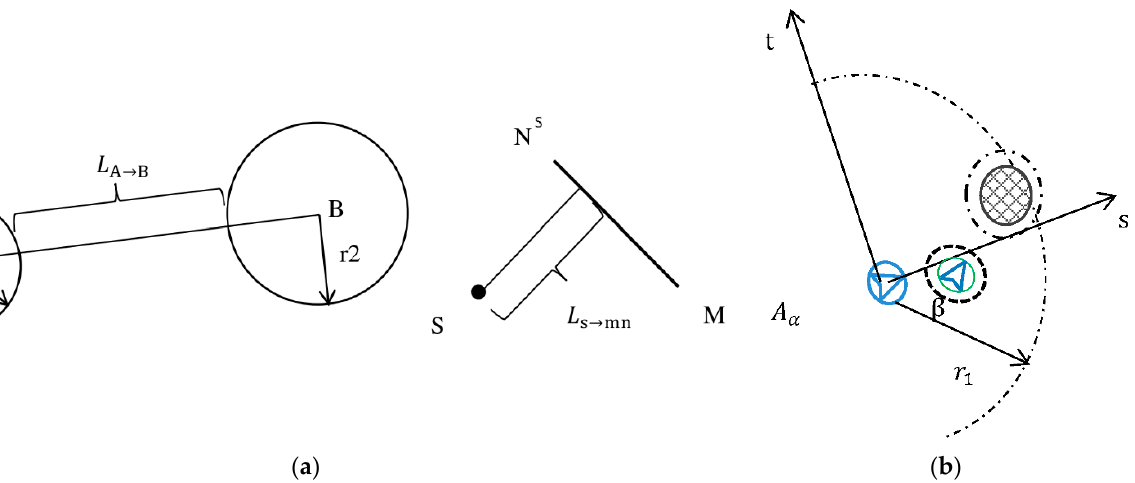
Figure 7. ( a ) Distance between two circles and point to the straight line. ( b ) Schematic diagram of the determination of the nearest obstacle element.